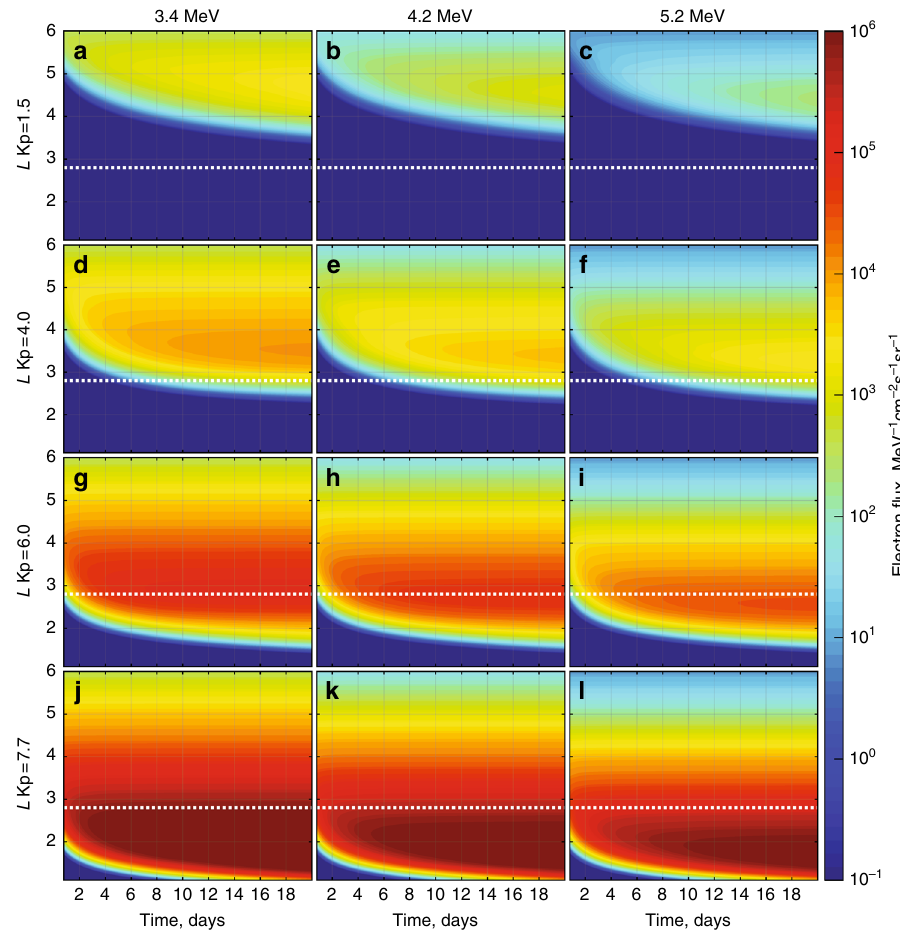
Fig. 3 Radial diffusion simulations showing the inward progression of electron fl ux over a 20-day interval driven by radial diffusion coef fi cients speci fi ed by different fi xed Kp- values. Each column shows the resulting fl ux at fi xed energies of 3.4 MeV (left), 4.2 MeV (middle), and 5.2 MeV (right) arising from transport at fi xed Kp of 1.5 ( a - c ), 4 ( d - f ), 6 ( g - i ), and 7.7 ( j - l ). The diffusion coef fi cients are speci fi ed by D LL [Ozeke] and the initial electron fl ux is set to zero such that the belts are created from inward ULF wave transport. The electron fl ux at the outer boundary ( L = 6) is speci fi ed using the mean electron fl ux at each energy channel measured by both Van Allen Probes A and B and derived from the entire period from 1 September 2012 to 31 May 2014. As is clearly shown, during active conditions the rates of radial transport from the outer simulation boundary to the heart of the radiation belt and beyond correspond to timescales on the order of a single magnetic